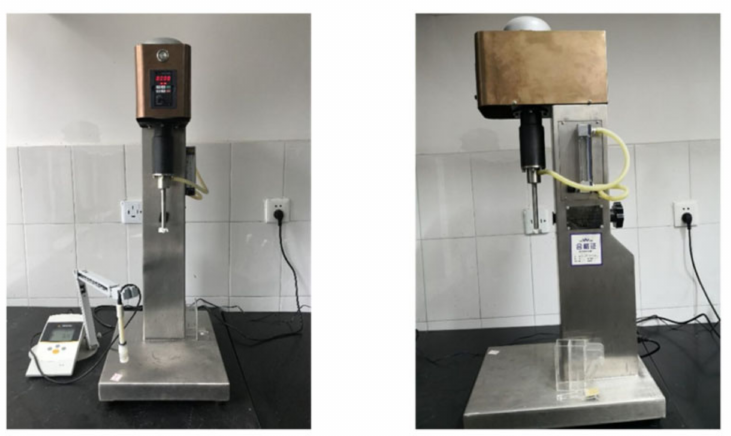
Figure 2. Schematic of XFG-II flotation